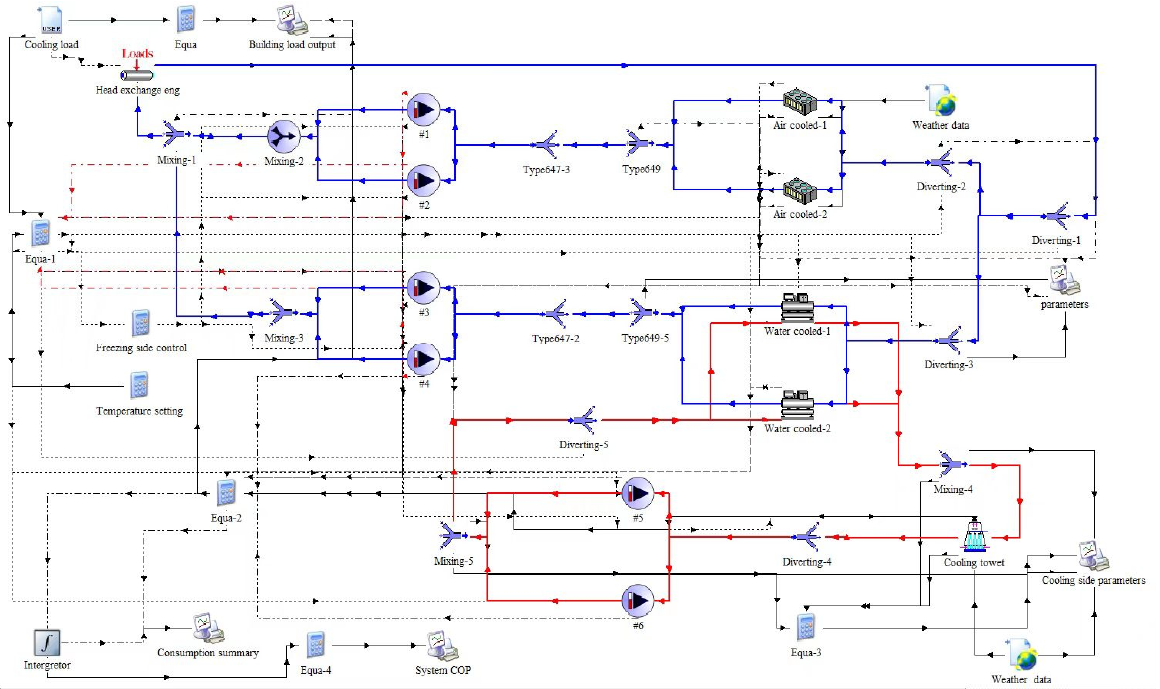
Figure 7. The simulation model of the refrigeration system based on the TRNSYS16 platform.